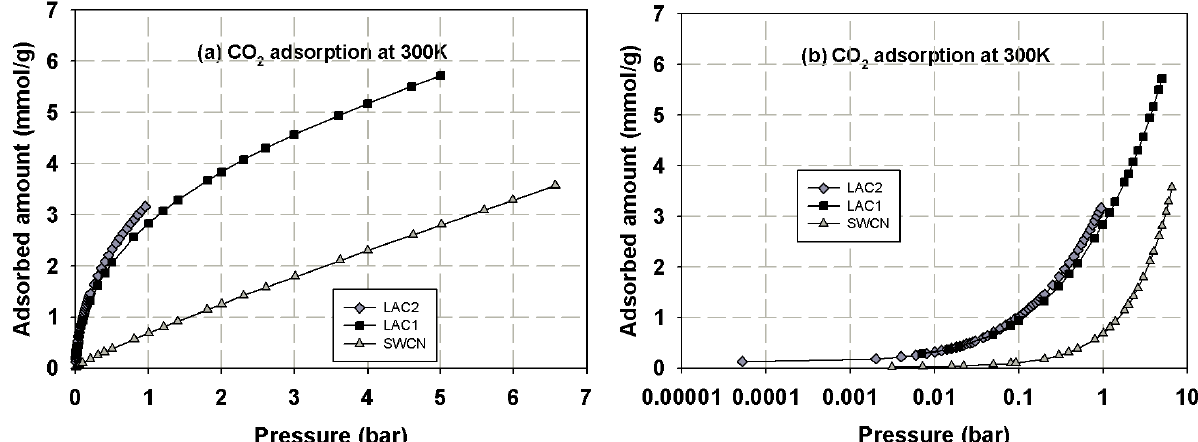
Figure 6. Adsorption isotherms of carbon dioxide at 300 K in various kinds of carbons in linear ( a ) and semi-log ( b ) scales.